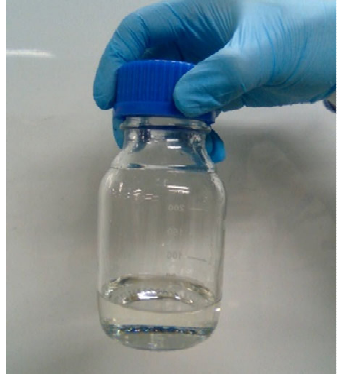
Figure 2. HKP110 fuel.